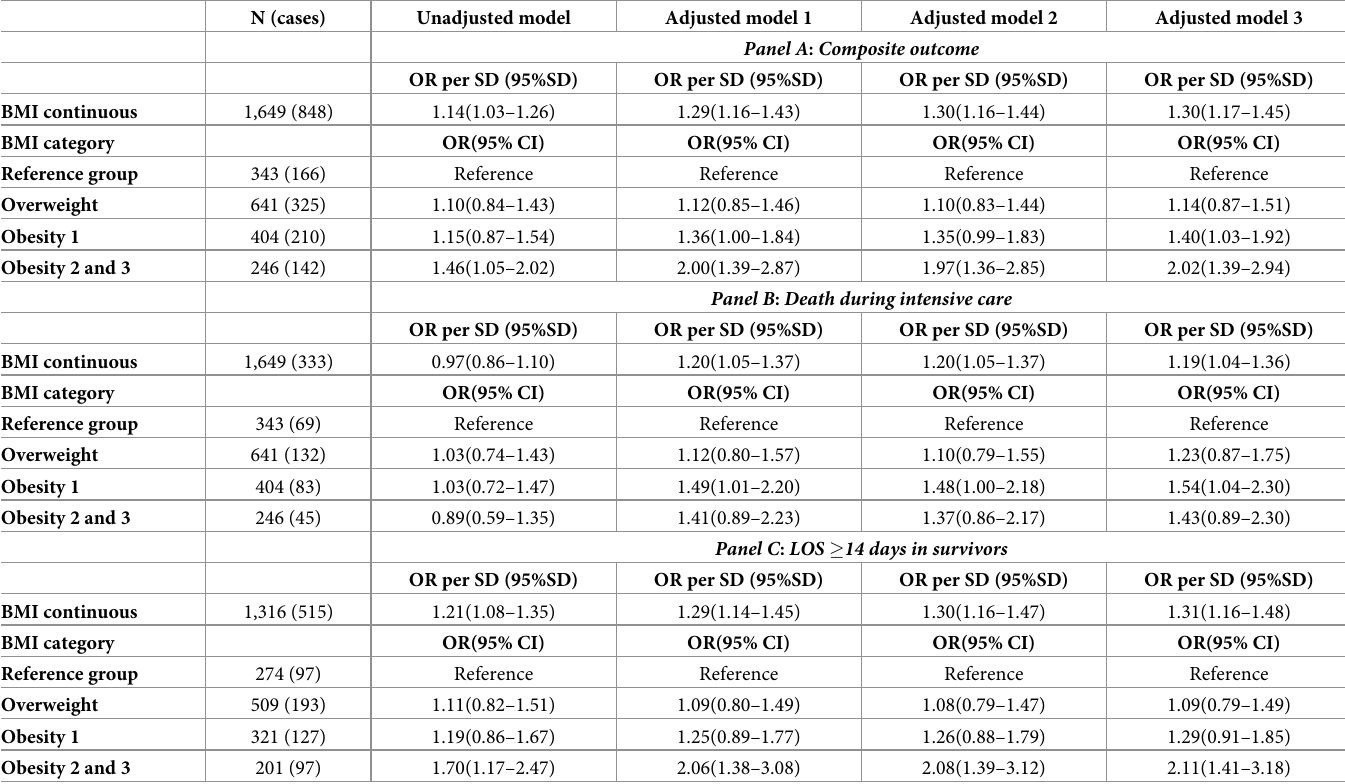
Table 3. BMI and BMI categories and the risk of composite outcome, death during ICU or ICU stay over 14 days. N (cases)